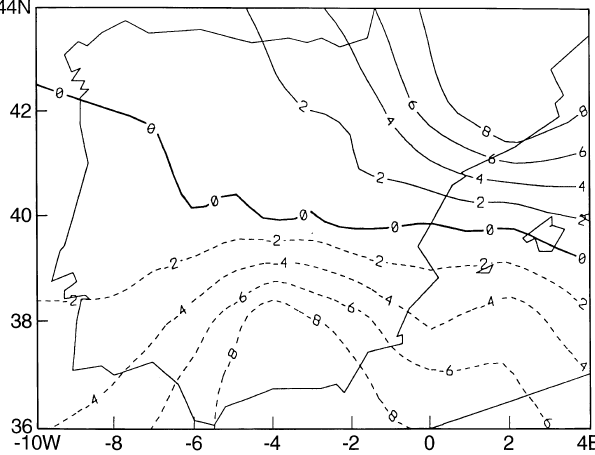
Fig. 6. Divergence of the Q-vectors (times -2) at 700 hPa for 1200 UTC 15 March 1990. Contour interval is 2 (cid:2) 10 (cid:255) 17 hPa (cid:255) 1 s (cid:255) 3